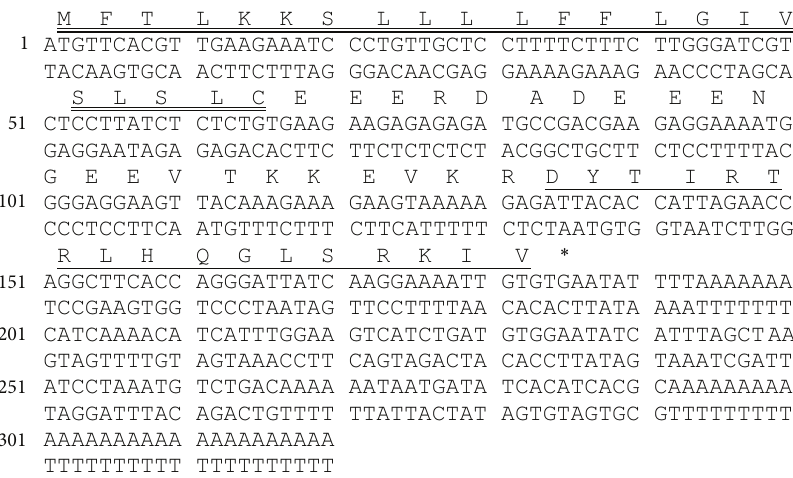
Figure 3: Nucleotide and translated open-reading frame amino acid sequence of cloned Pelophylax plancyi fukienensis skin secretion-derived cDNA encoding the biosynthetic precursor of the bradykinin inhibitory peptide, named ranakinestatin-PPF. The putative signal peptide id double-underlined, the mature peptide is single-underlined and the stop codon is indicated with an asterisk.